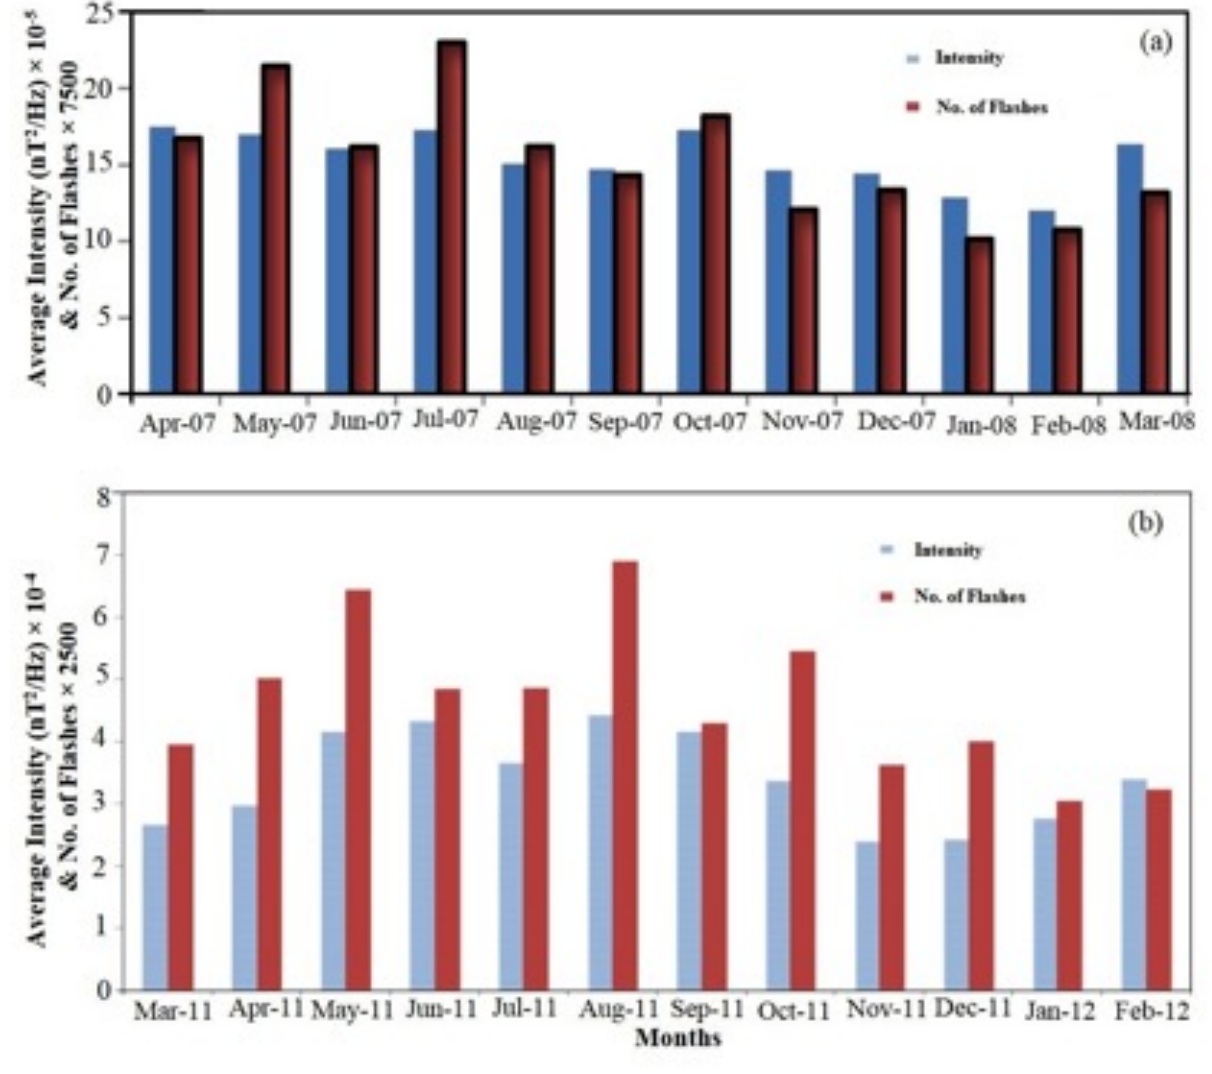
Figure 2. (a) Correlation between the global distribution of thunderstorm activities deduced from SR data at Agra for the period of 01 April, 2007 - 31 March, 2008 with Lightning Image Sensor (LIS) data on the satellite (b) the same as above but for the period of 01 March, 2011 - 29 February,